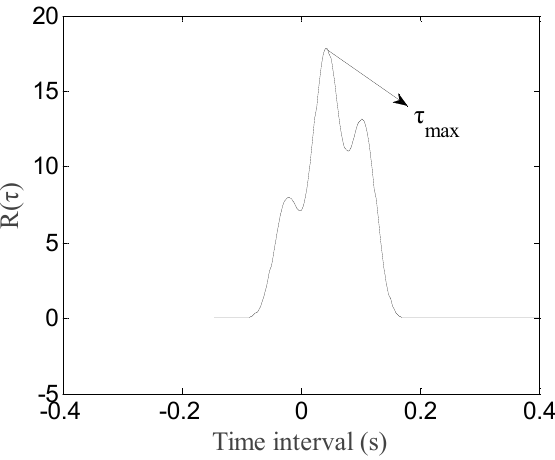
Figure 3. Cross-correlation function of measurement points N7 and N8.